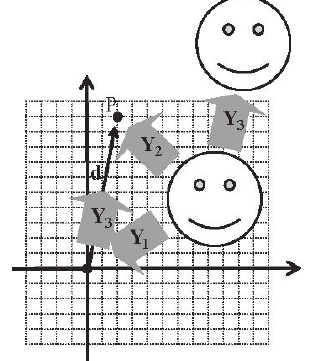
Figure 2 Affine magnification by Y The image of the object is the point at P. Y fine magnification by Y which is merely translation by d . If Y is displace by d without change in shape, size or orientation; Y then shrinks the object to a point at the